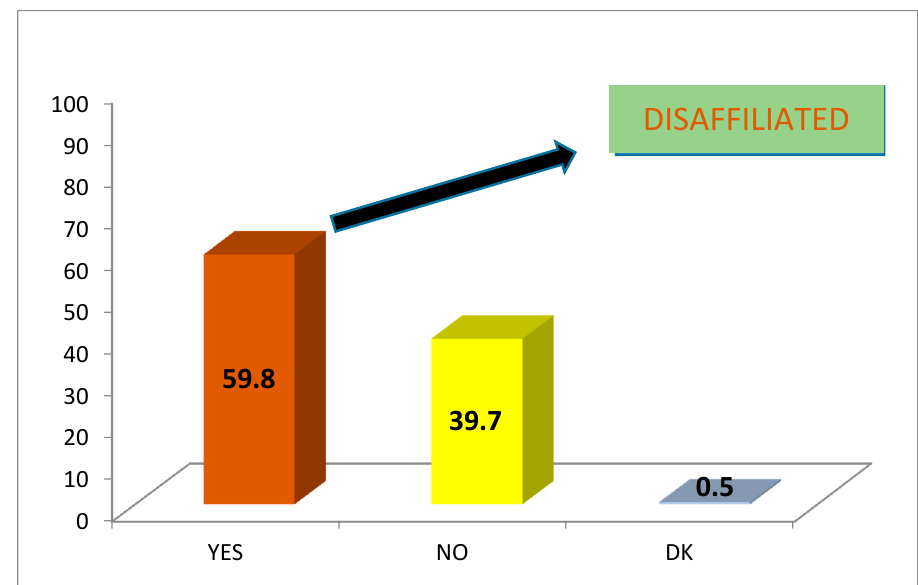
Figure 4. Changes in the affiliation of the religiously unaffiliated (in %). Based on 382 cases. Source: Author’s elaboration based on the Second National Survey on Religious Beliefs and Attitudes. Society, Culture and Religion Program, CEIL-CONICET, 2019.